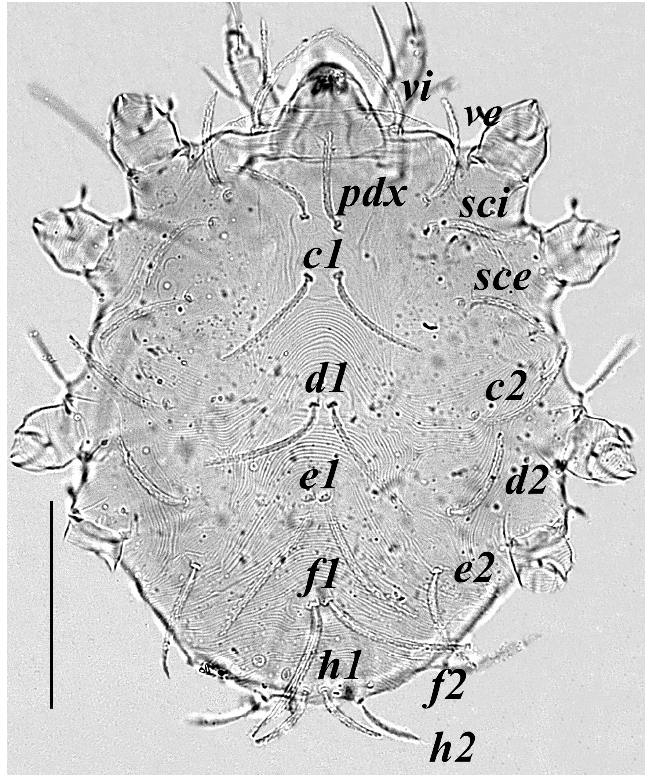
Figure 11. Neophyllobius fissus . Female. Dorsum. Scale bar: 100 μ m.